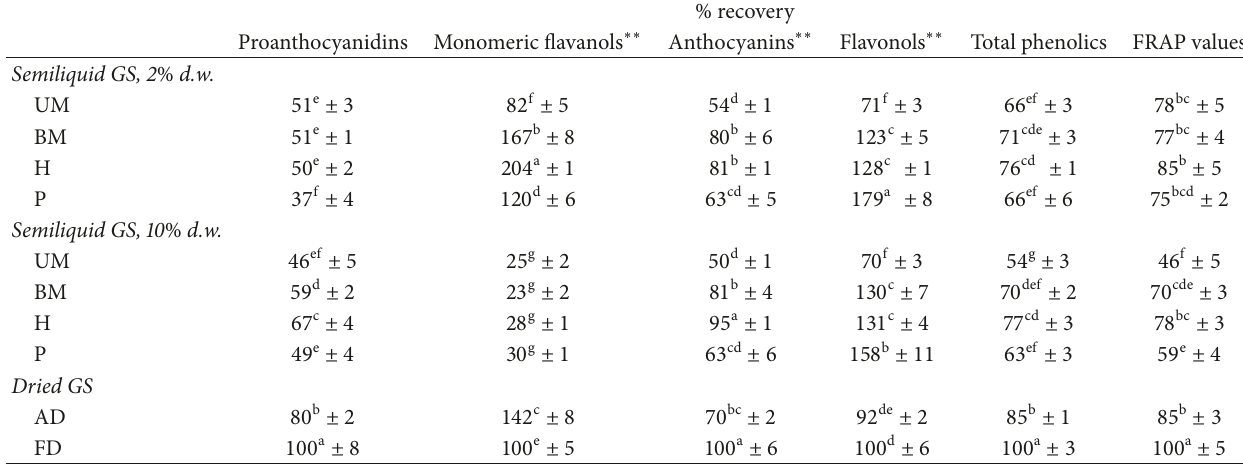
Table 1: Percent recovery of soluble proanthocyanidins, monomeric flavanols, anthocyanins, flavonols, total phenolics, and FRAP values after GS processing, considering the freeze-dried GS as a reference. ∗ % recovery Proanthocyanidins Monomeric flavanols ∗∗ Anthocyanins ∗∗ Flavonols ∗∗ Total phenolics FRAP values Semiliquid GS, 2 % d.w.